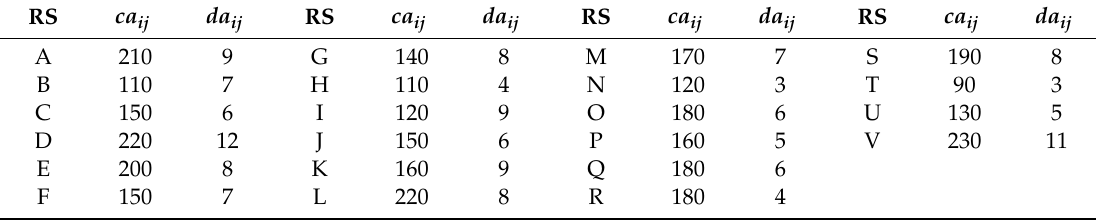
Figure 2. Layout of the supply chain network. Table 3. Restoration duration and cost of each disrupted road segment Table 1. Characteristics of all links.